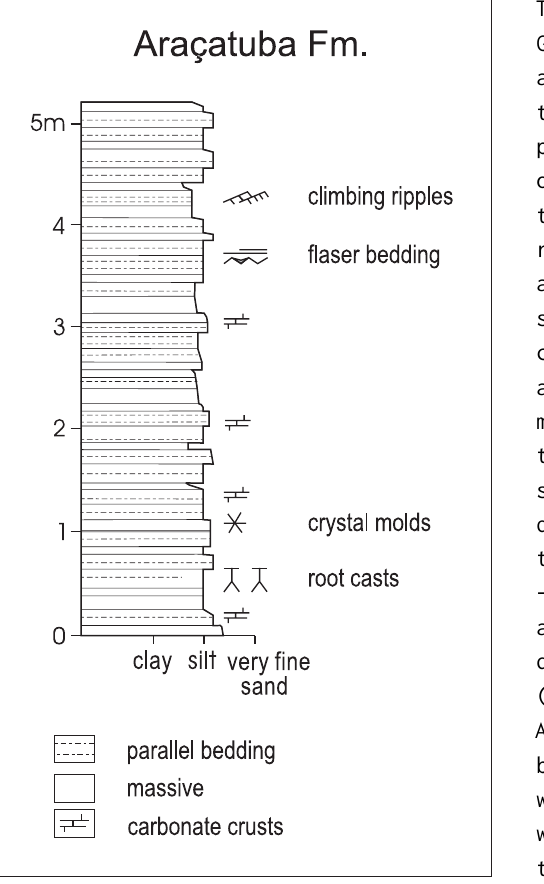
Fig. 5 – Araçatuba Formation type-section. Location: SP 300 highway, km 548.5, close to Araçatuba city (UTM: